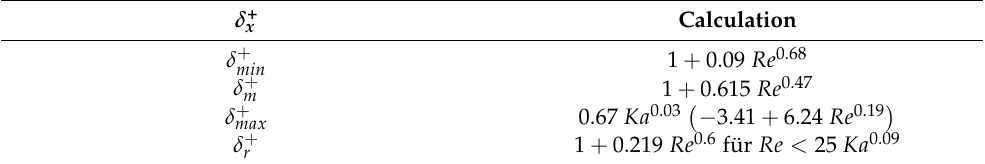
Table 2. Average, minimum, maximum, and residual non-dimensional film thickness [43].